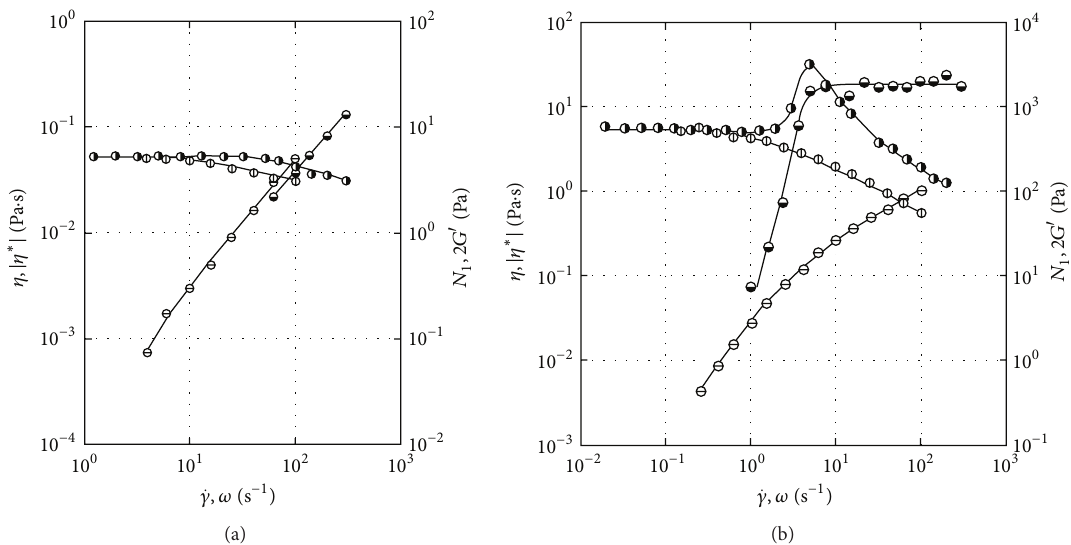
Figure 8: Response of polymer-flocculated 80nm copolymer particles for (a) 𝜑 = 0.05 and (b) 𝜑 = 0.20 . Viscosity ( T ) and first normal stress differences ( • ) in steady shear and magnitude of complex viscosity ( — ) and storage modulus ( ⊖ ) in oscillatory shear. (Reprinted from Otsubo [140], with permission from